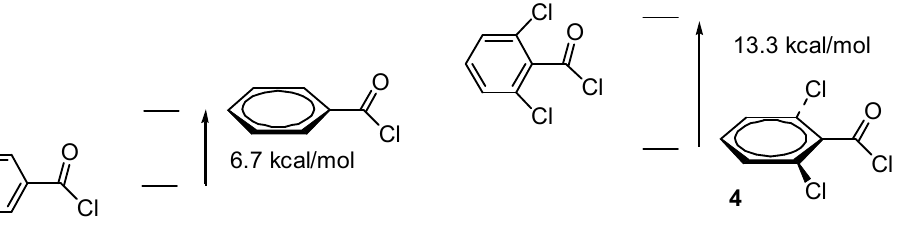
Figure 4. Preferred conformations of benzoyl chloride (planar) and 2,6-dichlorobenzoyl chloride ( 4 , perpendicular); barriers to rotation are shown (from HF/6−31G(d) calculations); the higher energy species of each pair were characterized as transition structures, having one negative